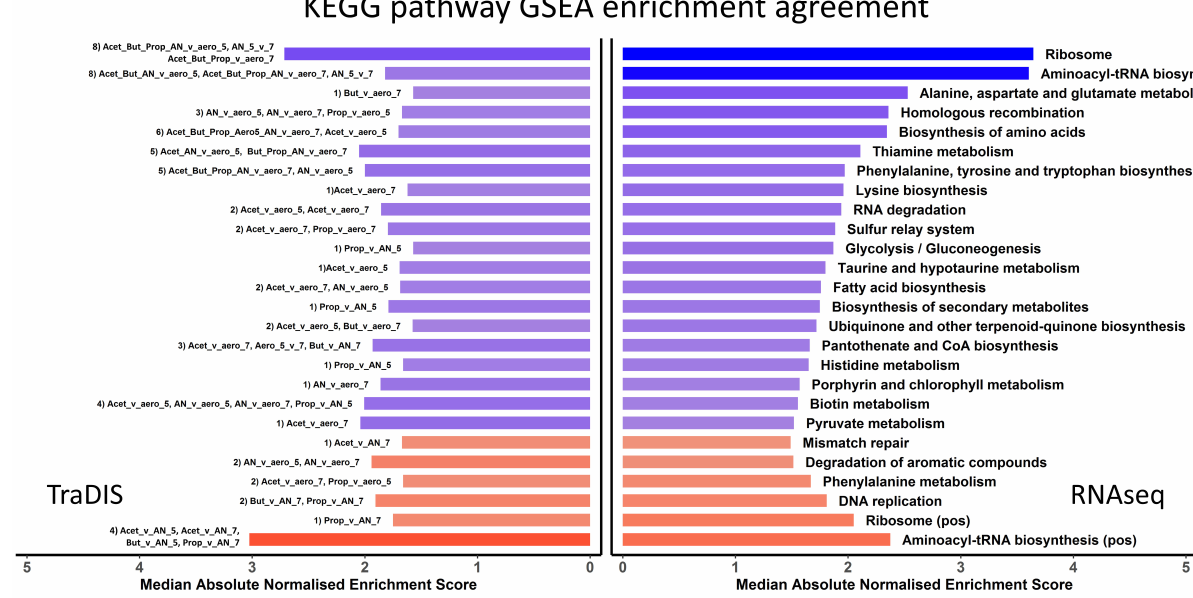
Figure 8. A total of 70 KEGG pathways where enrichments agreed between TraDIS and RNAseq for specific conditions. The horizontal bars represent absolute median normalised enrichment scores, where rows across both bar plots represent the same KEGG pathways enriched for both TraDIS and RNAseq, respectively. The KEGG pathway names are annotated on the right bar plot (RNAseq). The results are collapsed so each row is a non-redundant enriched KEGG pathway, and the conditions where they were seen are displayed as text on the left bar plot (TraDIS). As an example, the fatty acid biosynthesis pathway was found significantly enriched in two different comparisons; as can be seen in left bar plot for TraDIS data, labelled “2) Acet_v_aero_7, Acet_v_aero_5”. The “2)” shows that this pathway matched for two different comparisons for both RNAseq and TraDIS data, and the “Acet_v_aero_7” is shorthand for the contrast acetic acid vs. pH 7 aerobic control, and “4.Acet_v_aero_5” stands for acetic acid vs. pH 5.5 aerobic control. The median statistic was used for the bar plots where multiple samples agreed for the same KEGG pathway. Blue represents negative enrichment (i.e., enrichment of the KEGG pathway in the control sample) and red represents enrichment in the stress condition samples; the darkness of the colour corresponds to the significance of